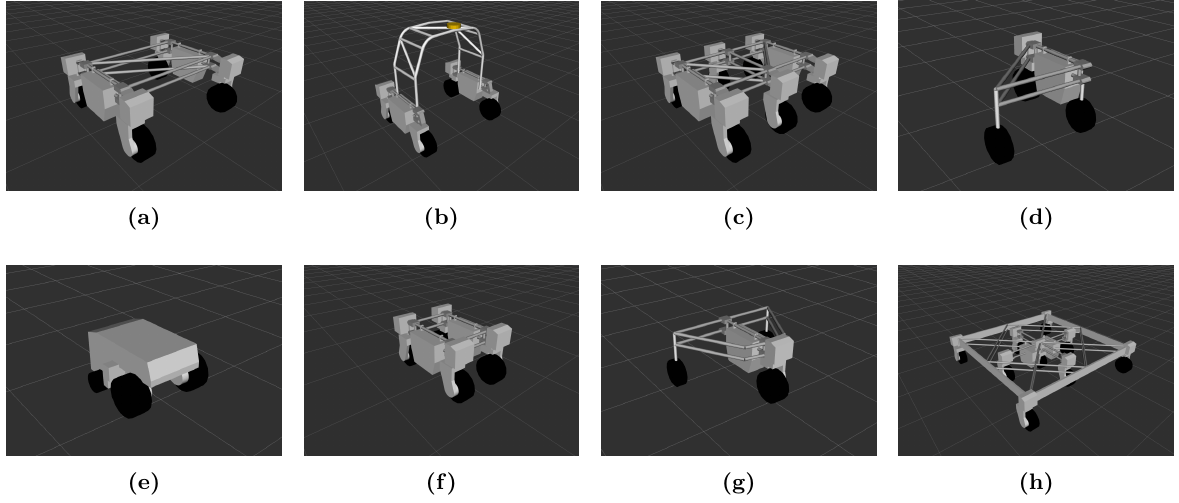
Figure 10: Robots generated by the presented system. ( a ) 4WD, 4WS, wide, with suspension, ( b ) 4WD, 2WS, custom tall frame, ( c ) 6WD, 6WS, with suspension, ( d ) 1WD, 1WS, rear-wheel drive, ( e ) 2WD, 0WS, custom frame, ( f ) 4WD, 4WS, slim, ( g ) 1WD, 1WS, front-wheel drive, ( h ) 9WD, 9WS.